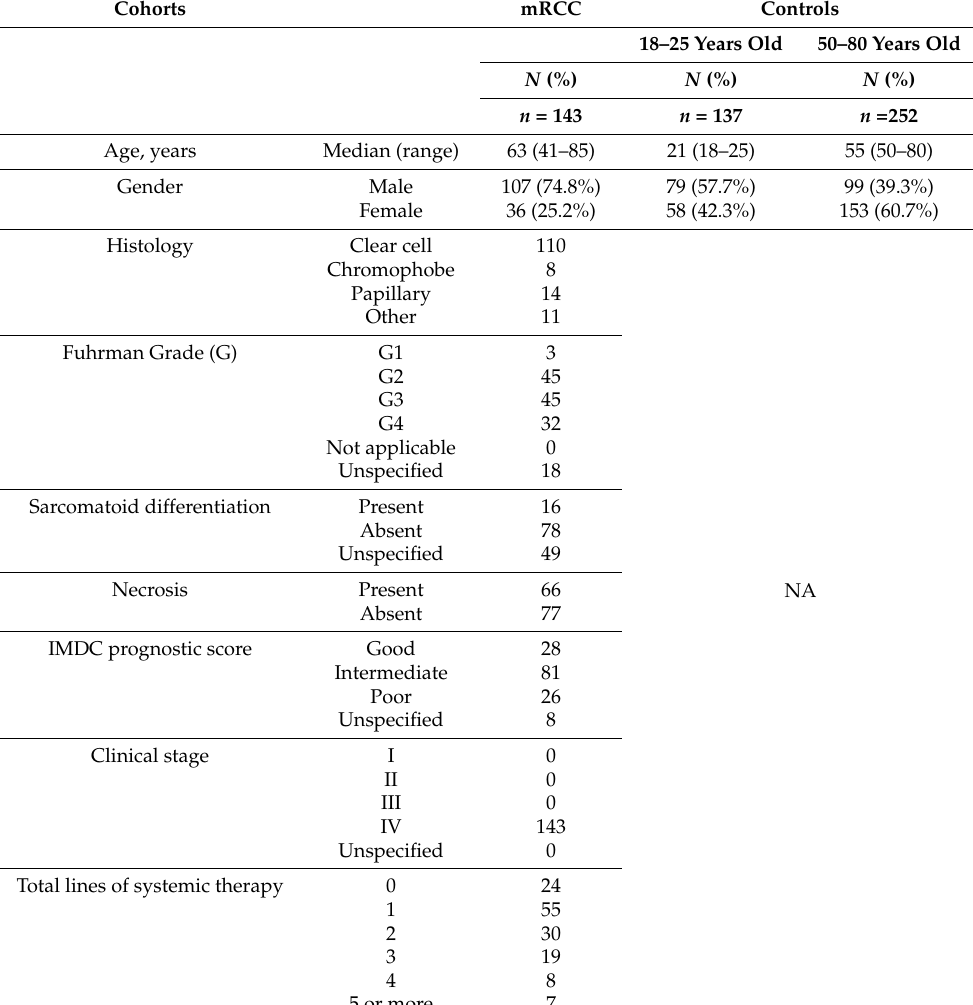
Table 1. Clinical and pathological characteristics for mRCC patients and control